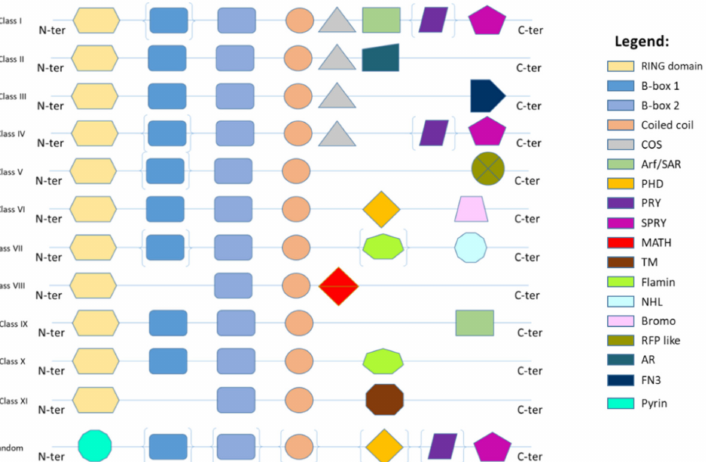
Figure 1. Classification of TRIM/RBCC proteins. The N-terminal domain (N-ter) is mostly conserved in TRIM family members and includes RING, B-box 1, B-box 2 and coiled-coil domains. A variable C-terminal domain (C-ter) classifies TRIMs into 12 different classes and includes COS box motif, ARF (ADP ribosylation factor)/SAR, PHD (Plant Homeodomain), PRY, SPRY (SPla and the RYanodine receptor), MATH (meprin and TRAF homology domain), TM (transmembrane motif), FILAMIN, NHL (NCL1/HT2A/LIN-41), Bromo domain, FN3 (FibroNectin type III motif), and a variable domain. The presence of certain domains can vary even among members of the same class, as indicated by